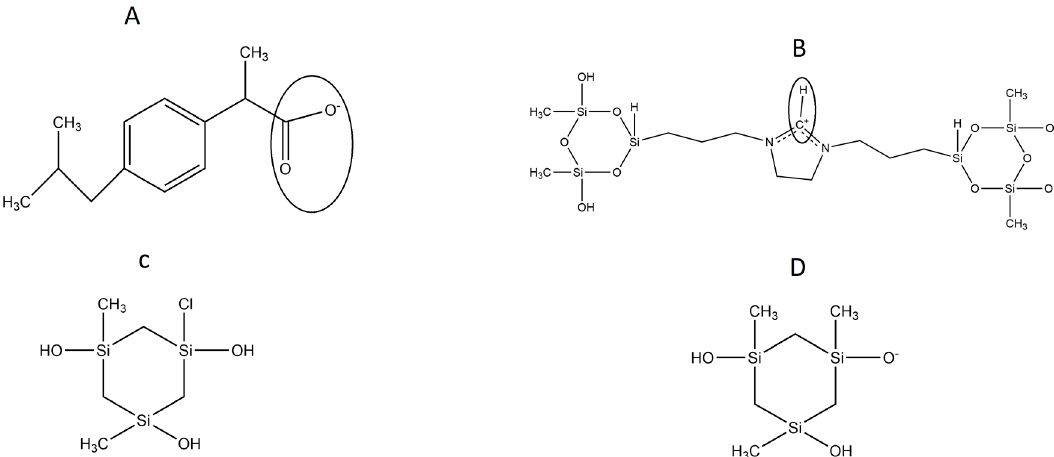
Figure 1. Chemical structure of the simulated molecules. A = Ibuprofen, IBU; B = Dehidroimidazolium motif modified with silica trimers, ORMOSIL, DHI + ; C = Cyclic silica trimer, SI3; D = Anionic form of the cyclic silica trimer, SI − . The circles show the atoms considered in the calculation of the RDF.